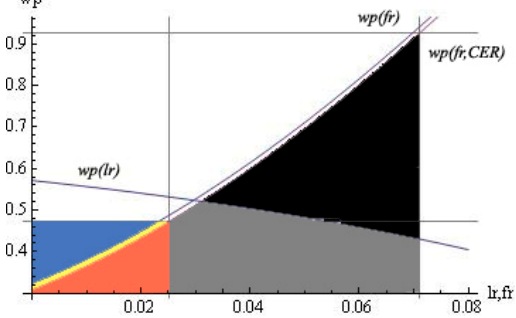
Figure 3. Characterization of a financially feasible but socially unsustainable irrigation project. Financial feasibility exists for 13.3% of the reliable economic solutions but no solution is socially sustainable. Black, unreliable solutions, infeasible for farmers and the government; grey, unreliable solutions, feasible for farmers but not for the government; light red, feasible for farmers but not for the government; light yellow, feasible for farmers and feasible for the government if it sells CER credits; light blue, feasible for farmers and for the government without selling CER